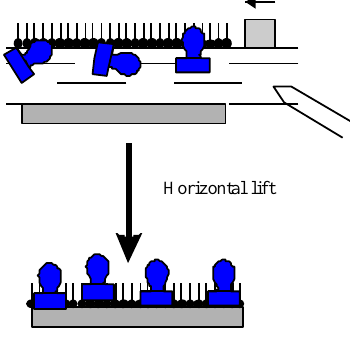
Figure 2. Langmuir-Schaefer deposition of Langmuir monolayer onto the solid support; –protein ( i.e. , enzyme), –amphiphilic molecule ( i.e. ,